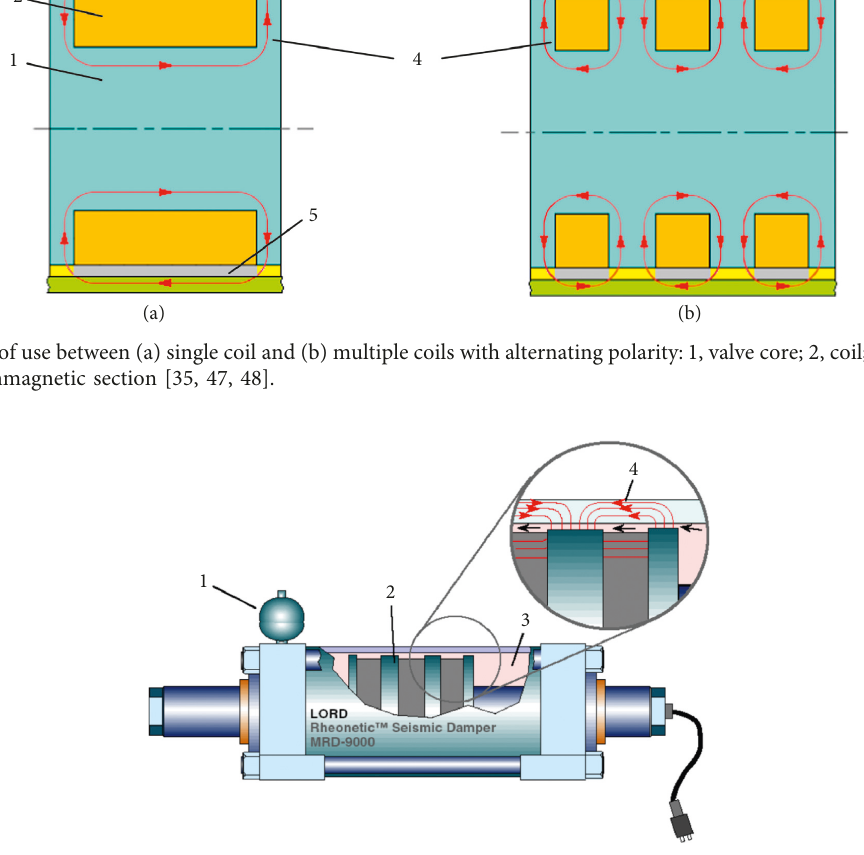
Figure 5: Schematic of 200kN seismic damper: 1, thermal expansion accumulator; 2, 3-stage piston; 3, MRF; 4, magnetic flux [36, 37].